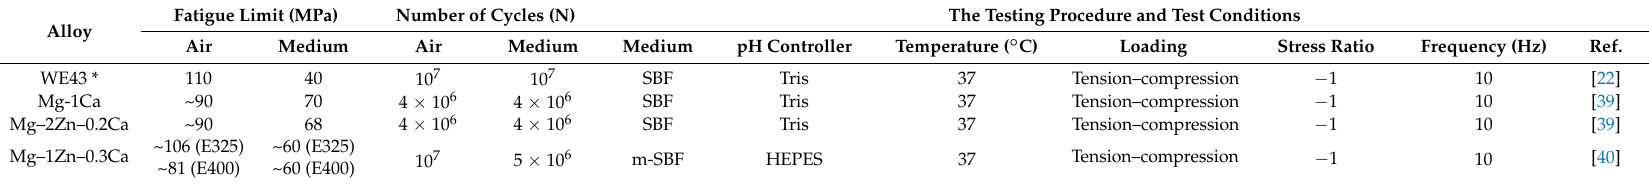
Table 3. Comparison of fatigue limits and experimental set-ups employed to evaluate the fatigue life of Al-free Mg alloys in SBF.